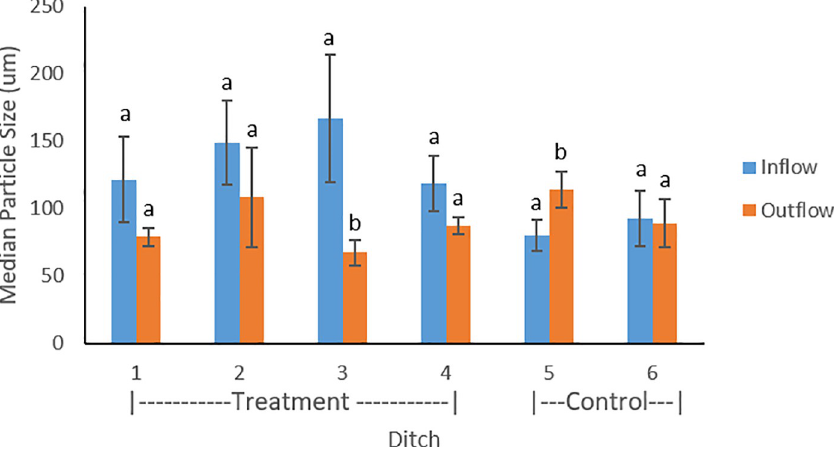
Fig 4. Median particle size compared between inflow and outflow of the treatment (1–4) and control ditches (5– 6). Error bars represent standard deviations throughout the three sampling periods.